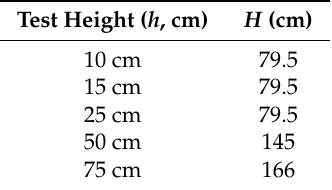
Table 2. Different heights of the spheres ( h ) and the horizontal round bar ( H ) in the experiments.